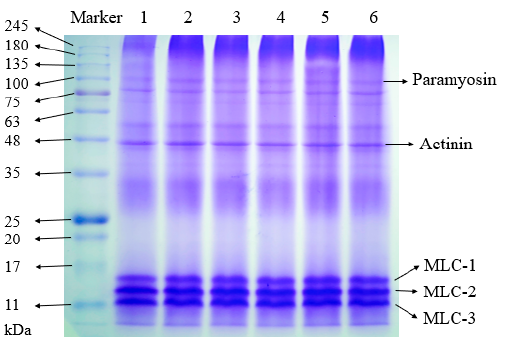
Figure 5. SDS-PAGE of control and HP treated oyster proteins under reducing conditions. Lanes 1–6 represent 0.1, 100, 200, 300, 400, and 500 MPa, respectively.